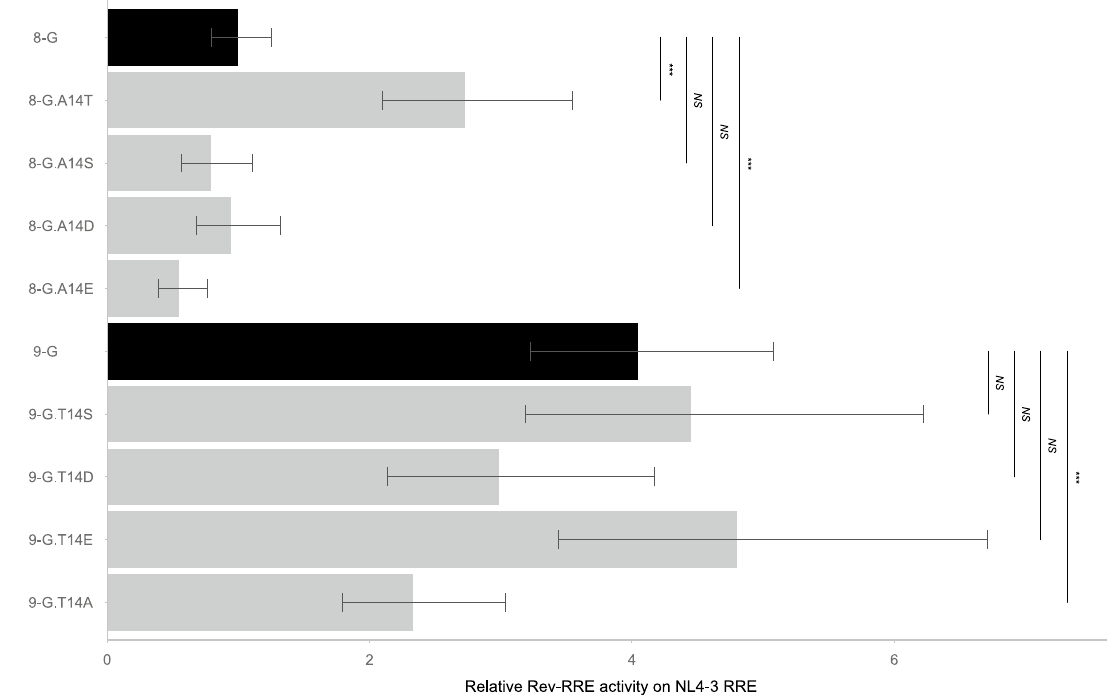
Figure 6. Activity of Revs with phosphomimetic substitutions on NL4-3 RRE. Revs with phosphomimetic amino acid substitutions at position 14 were created and their functional activity determined on the NL4-3 RRE using the fluorescence-based assay system. The native 8-G and 9-G Rev sequences are included in dark bars for reference and modified Revs are in light bars. Relative activity is expressed in arbitrary units with the activity of the 8-G Rev/NL4-3 RRE pair defined as 1. The statistical comparison is performed is performed between the Revs indicated by the vertical bars. N ≥ 3 for all data points, error bars represent 95% CI. NS —not significant, *** p < 0.001.